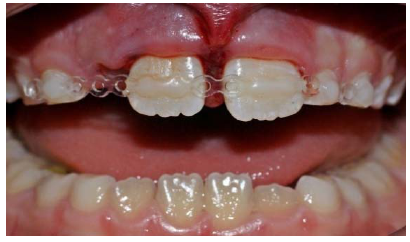
Figure 8. The power chain splint in a patient after a trauma of 11 and 21 with a missing adjacent tooth.